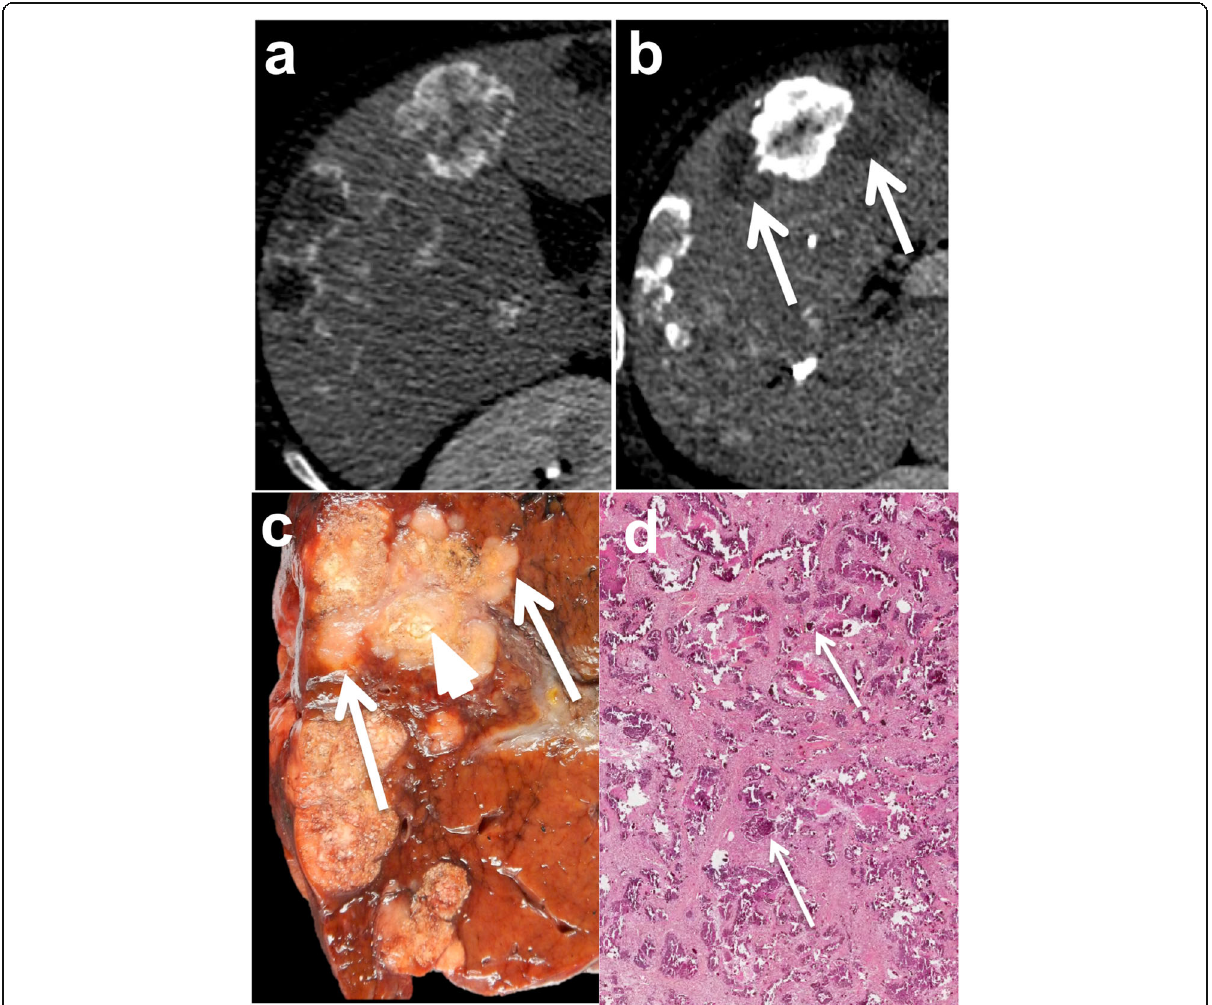
Fig. 14 Calcifications of liver metastases induced by chemotherapy in a 38-year-old female patient with non-otherwise specified adenocarcinoma of the sigmoid treated with preoperative chemotherapy (FOLFOX and anti-EGFR). Portal venous phase contrast-enhanced CT scan obtained after 12 cycles of chemotherapy ( a ) shows several liver hepatic metastases with fine calcifications. The preoperative CT-scan performed 12 months later after multiples additional cycles of chemotherapy and right portal vein embolization ( b ) shows densification of calcifications and the appearance of areas of peripheral tumor regrowth (white arrows). Gross pathology ( c ) confirmed the presence of calcified (white arrowhead) necrotic metastasis with peripheral viable tumor (white arrows). Histology ( d ) showed the presence of extensive necrosis partially mineralized with calcium deposits (white thin